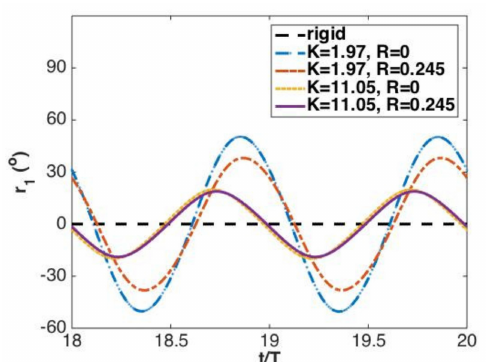
Figure 8. Induced instantaneous pitch angle of passive joint.